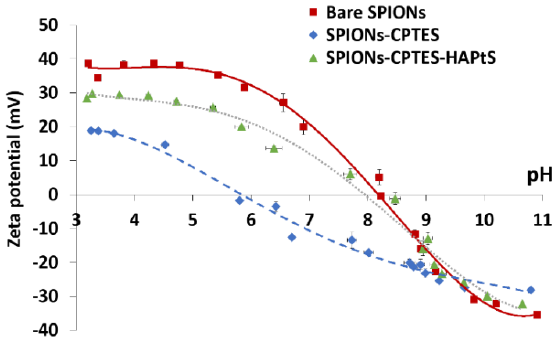
Figure 6. Zeta potential measurements of bare and functionalized SPIONs (10 -2 M NaCl).